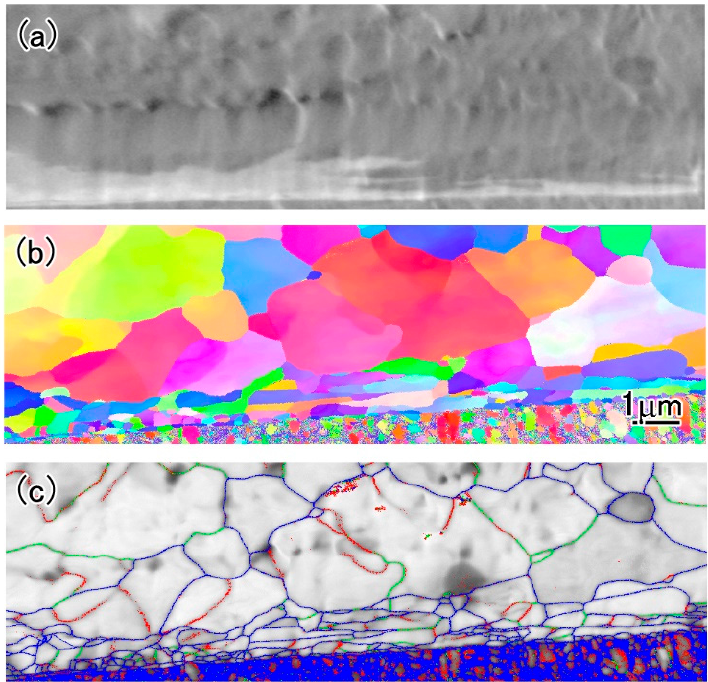
boundary map. In this map, blue lines indicate that the grain boundary misorientation is over 15 ◦ , and the grain boundary is a high angle grain boundary. Green lines indicate that the rotation angle ranges from 15 ◦ to 5 ◦ . Red lines indicate that the rotation angle is less than 5 ◦ . It was found that the Ag layer mostly consisted of high angle grain boundaries, and the Cu grains contained many small angle grain boundaries.